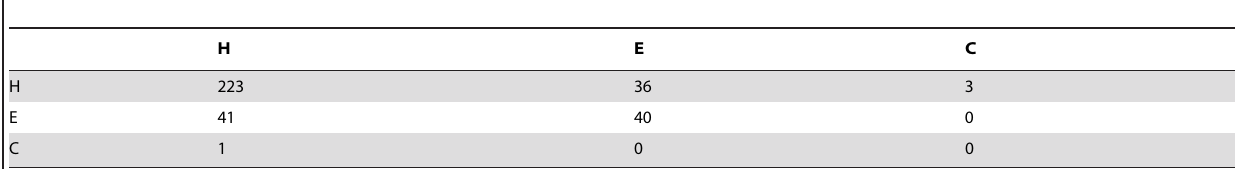
Table 3. Total number of INVPEPs observed in helix (H), strand (E) and coil (C) conformation among 1625 ‘swappable’ INVPEPS.